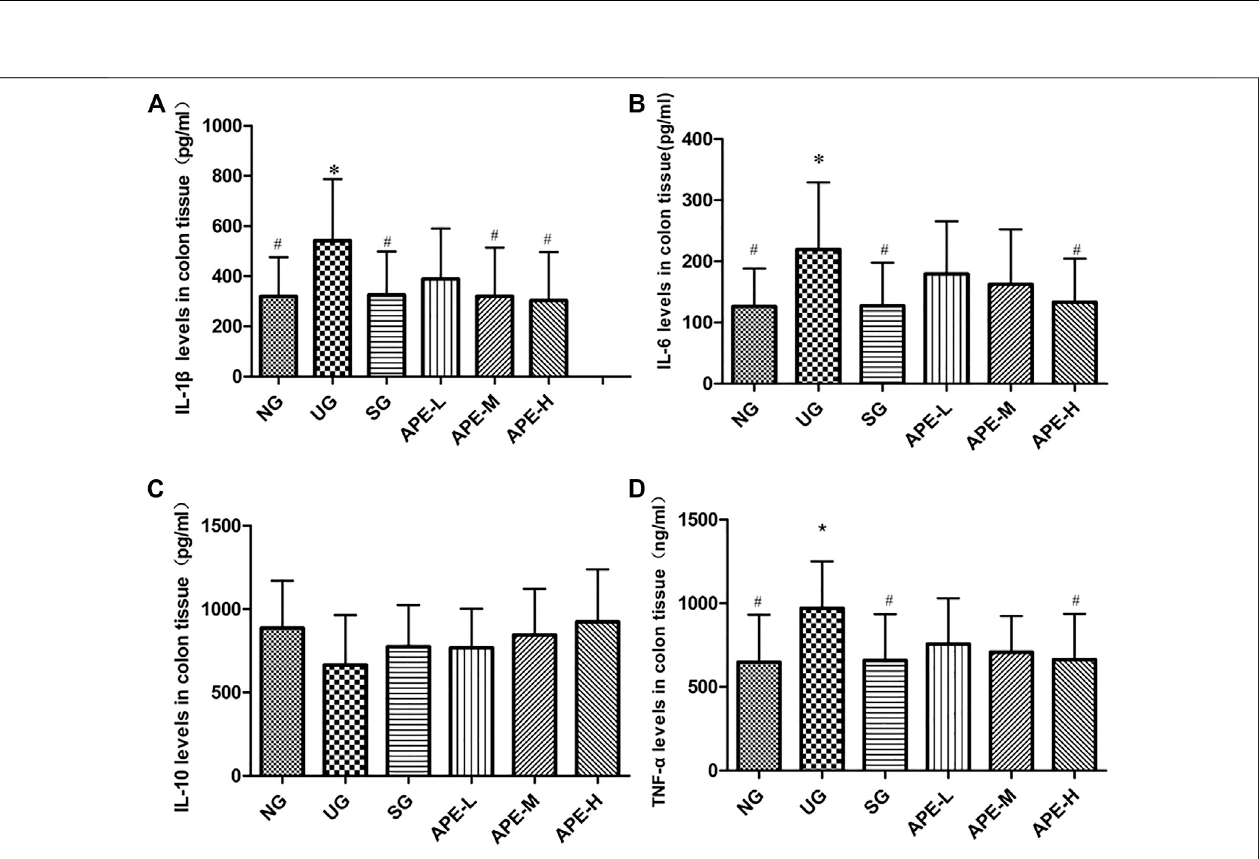
FIGURE6| EffectsofAPEonthecolontissuelevelsofin fl ammatoryfactorsintheUCmice. (A) IL-1 β . (B) IL-6. (C) IL-10. (D) TNF- α . n (cid:2) 8foreachgroup.* p < 0.05,** p < 0.01vs. NG. # p < 0.05, ## p < 0.01vs. UG.APE, Alhagipseudalhagi extract;UC,ulcerativecolitis;IL-1 β ,interleukin-1 β ;IL-6,interleukin-6;IL-10,interleukin-10;TNF- α , tumor necrosis factor- α ; NG, normal group; UG, ulcerative colitis model group; APE-H, high-dose APE group; APE-M, middle-dose APE group; APE-L, low-dose APE group.